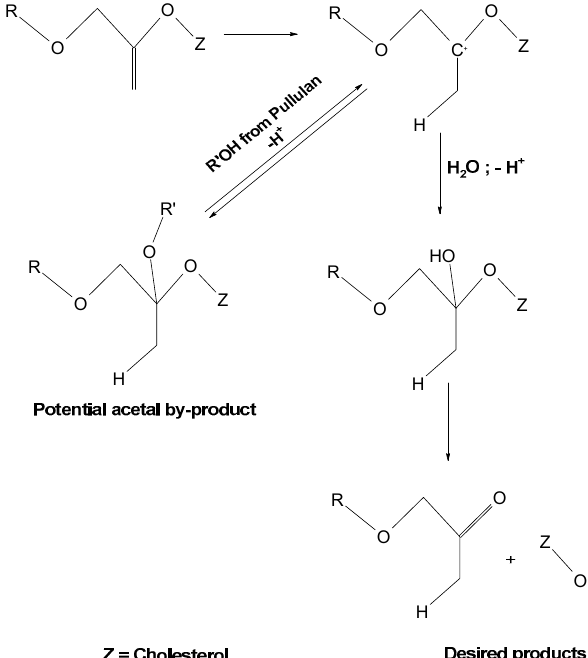
Figure 11. Representation of the pullulan chemical structure.